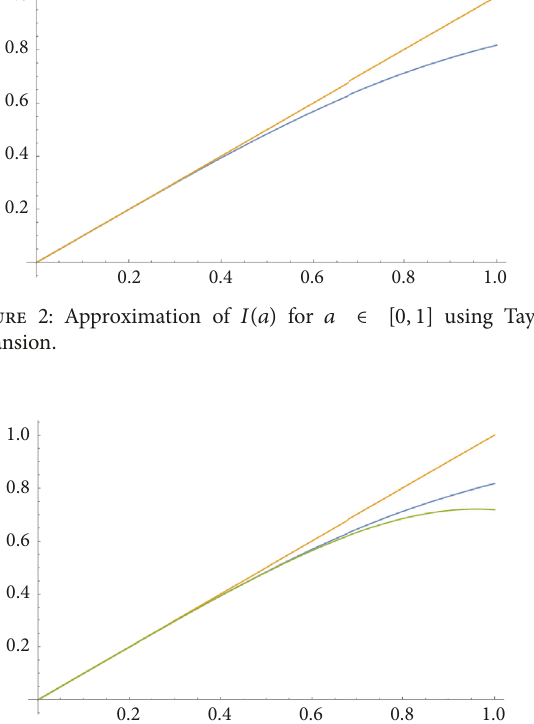
Figure 3: Plot of I(a) with both